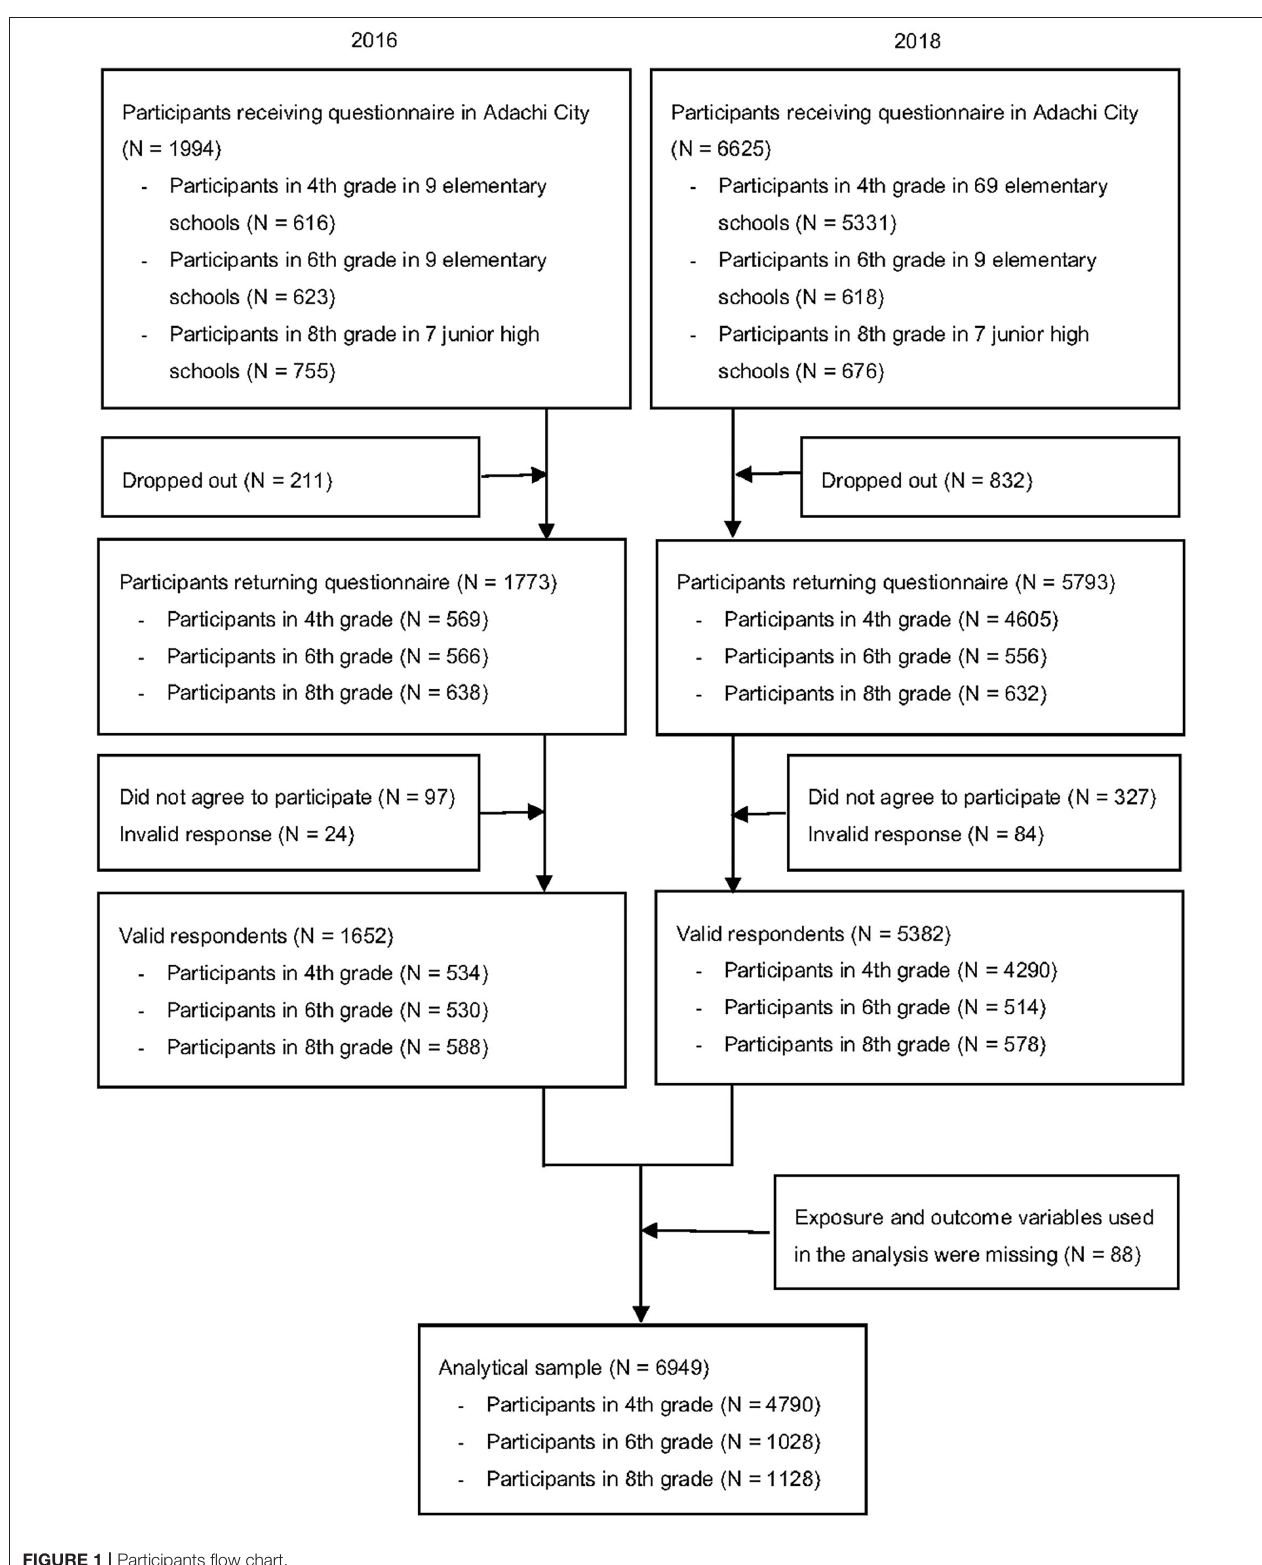
FIGURE 1 | Participants flow